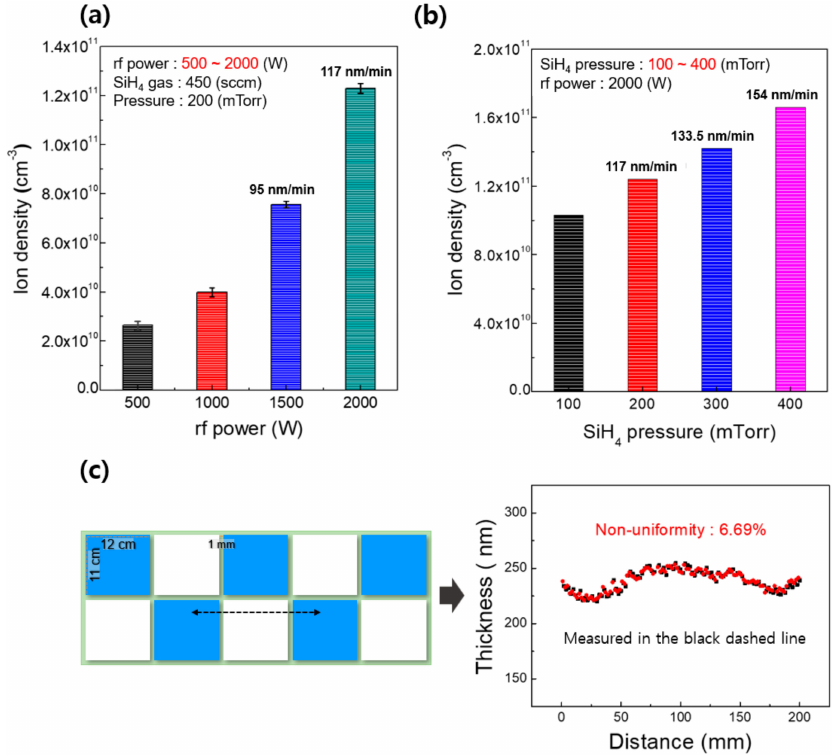
Figure 2. Ion density measured using a Langmuir probe ( a ) at different RF powers (500~2000 W) and ( b ) different SiH 4 pressures (100~400 mTorr) in a VHF (162 MHz) plasma source with multi-split electrodes. ( c ) The schematic diagram of multi-split electrodes, with the thickness/non-uniformity measured at 1 mm intervals in a 200 mm region of an a-Si thin film deposited using the VHF (162 MHz) plasma source at 2000 W, 200 mTorr, and 80 ◦ C substrate